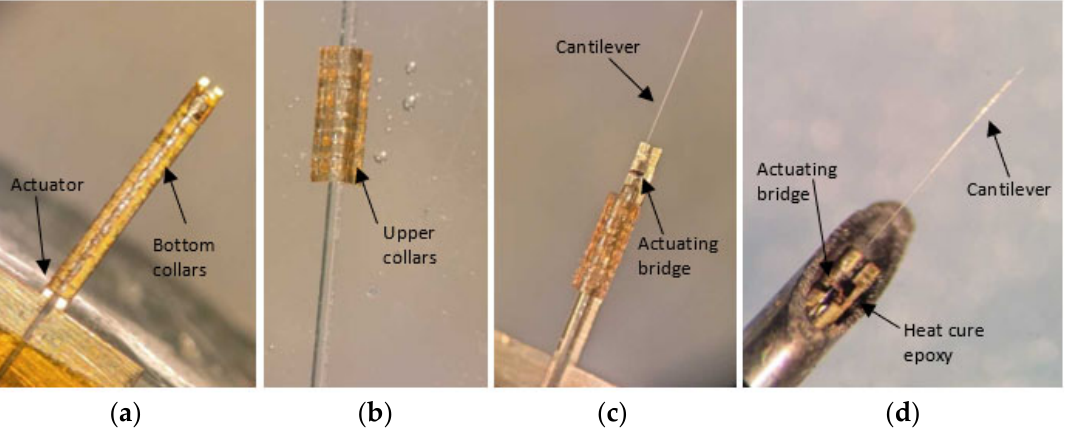
Figure 2. Assembly of the proposed scanner: ( a ) Bottom SU-8 collars are placed in the groove of actuator and glued together; ( b ) upper U-shaped SU-8 collars are attached to the portion of the fiber away from cantilever end; ( c ) two parts are connected; ( d ) assembly is covered with heat cure epoxy, placed in the nitinol tube and